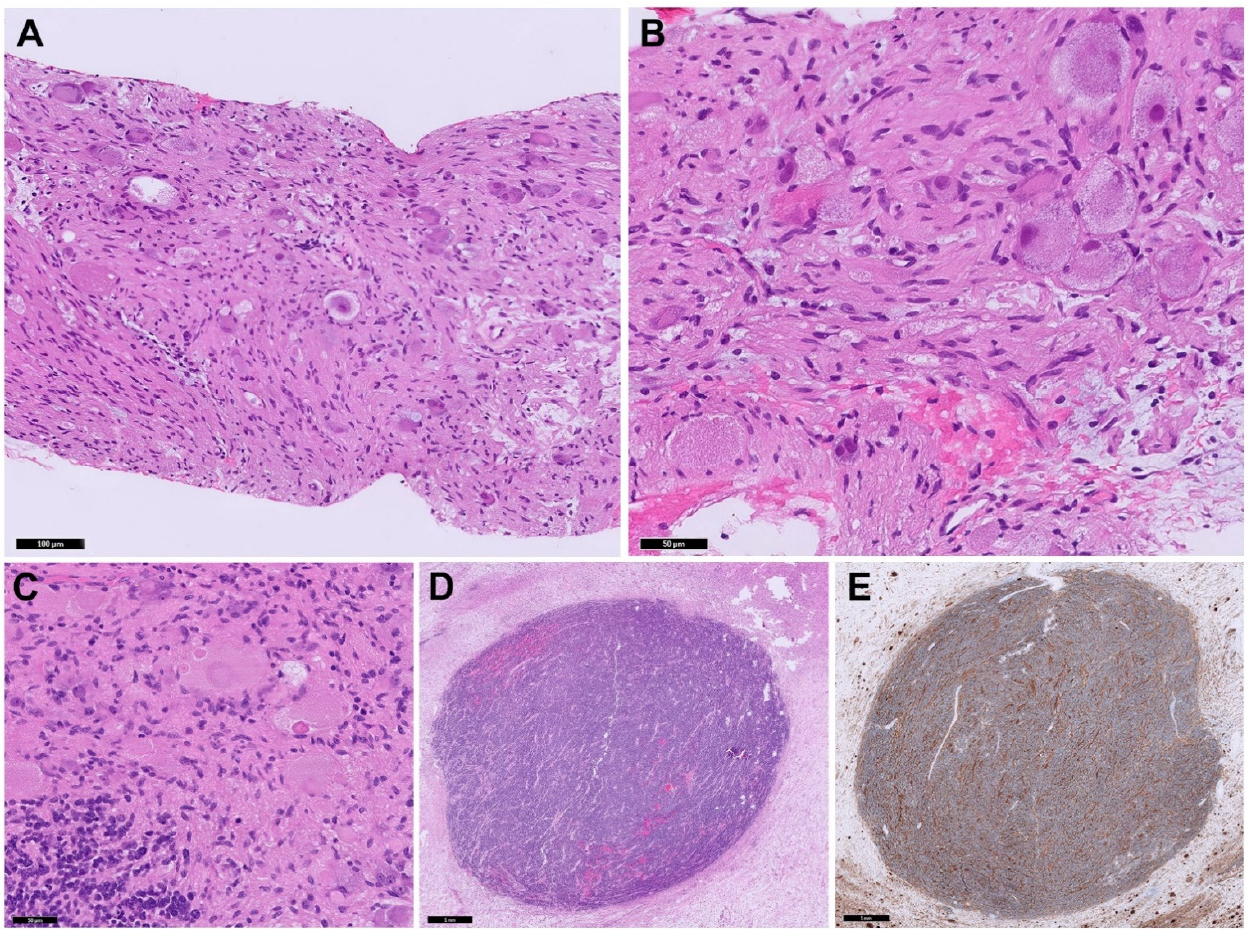
Figure 5. Microscopic examination of the neoplasm. On the increased uptake found at 18 F ‐ FDG PET in the abdominal mass, the child underwent laparotomic partial excision of the abdominal mass: ( A , B ) Needle core biopsy of the thoracic lesion showed a GNBI morphology (H&E stain); ( C ) Surgical excision of the abdominal mass revealed a GNBN morphology showing well ‐ defined nodules ( D ) of Schwannian stroma ‐ poor NB, poorly differentiated (H&E stain). ( E ) Synaptophysin immunoperoxidase stain highlighting stroma ‐ poor nodules. In addition, NB undifferentiated foci were documented in a lymph node. Restaging included a bone marrow aspiration and biopsy, which ruled out osteo ‐ medullary infiltration.